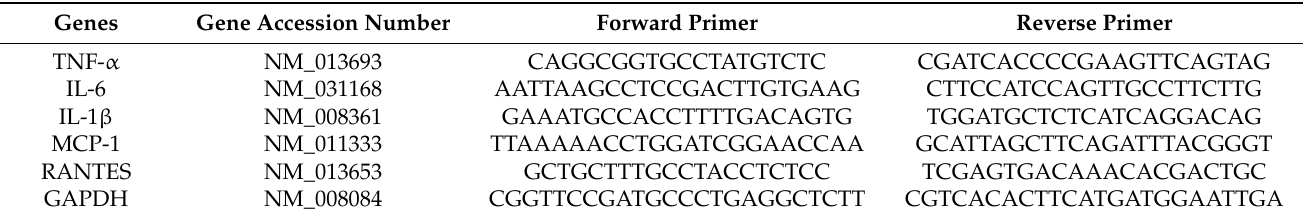
Table 1. Sequences of